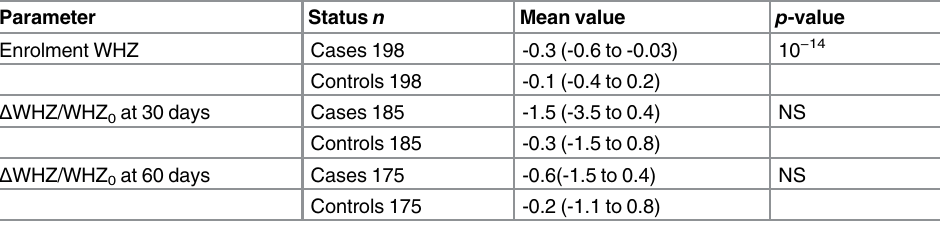
Table 4. Comparison of weight-for-height or length (WHZ) scores at enrolment, and change in WHZ ( Δ WHZ/WHZ 0 ) between enrolment and follow-up at 30 and 60 days, between children with diarrhea and their matched controls from Antananarivo and Moramanga, 2011 –